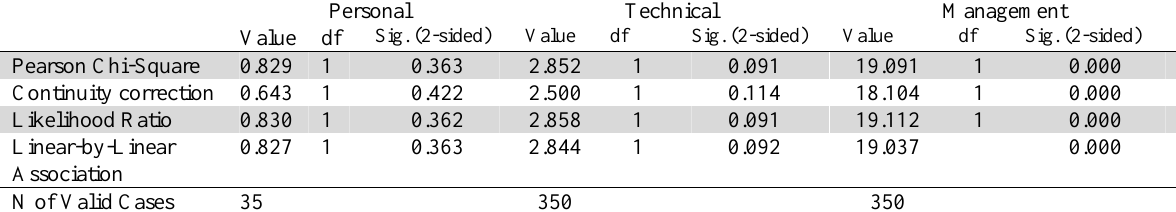
The results of Chi-Square test for the effect of